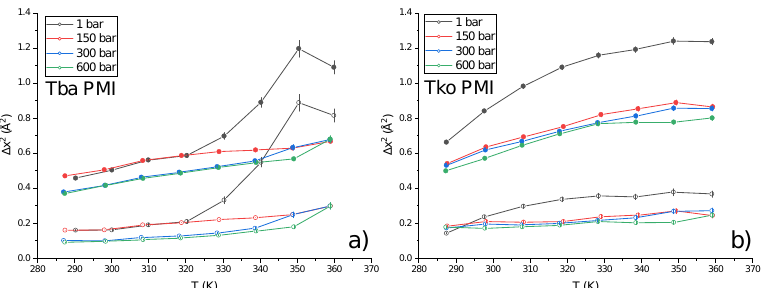
Figure 4. Total MSD (full circles) and MSD into the single wells ( ∆ x 2 , open circles) for Tba PMI ( a ) 0 and Tko PMI ( b ), lines are a guide to the eye. The absolute value of the MSD reports on the amplitude of hydrogen atoms motion, while the slope of the curve as a function of temperature indicates how much energy is necessary to increase said amplitude, i.e., the resilience of the protein [32]. These results are in line with those from whole-cell studies on the same two organisms, which demonstrated the higher flexibility of the proteome of T. barophilus [6,7,34] and the ex- istence of pressure-induced structural rearrangements [7,34] in this strain. For T. barophilus , the transition occurs smoothly between 1 and 300 bar, close to the optimal growth pressure for the organism, i.e., 400 bar [35]. In T. kodakarensis , the transition takes place at a